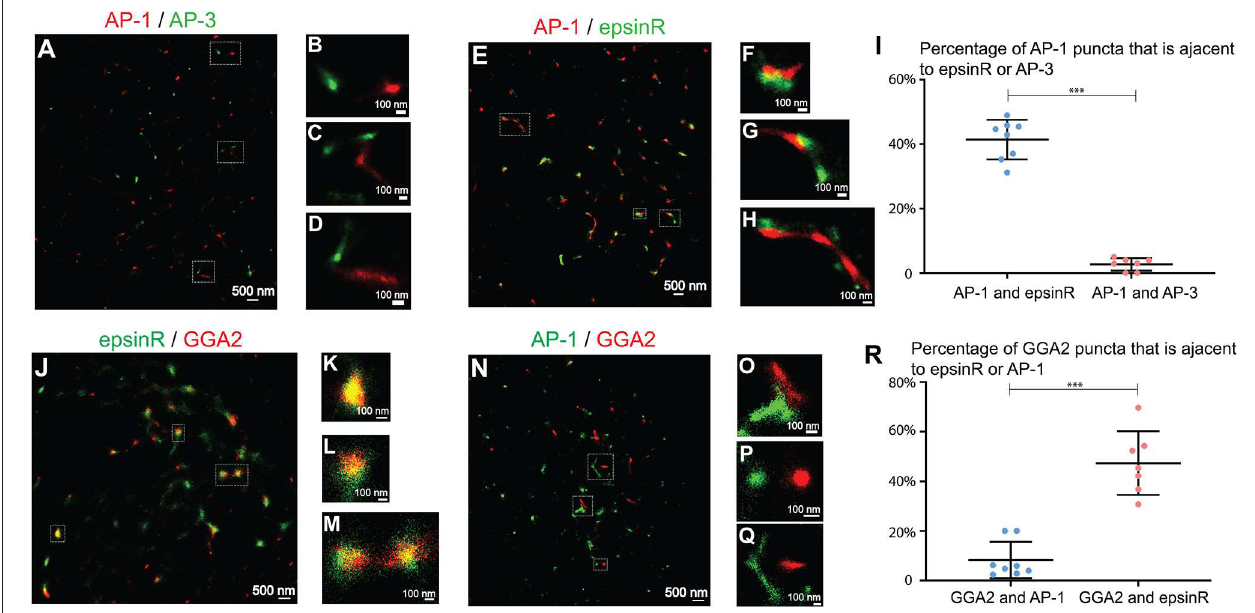
FIGURE 3 | Spatial relationship analysis between clathrin adaptors at the juxtanuclear area. (A–D,N–Q) COS7 cells were co-stained with antibodies against γ 1-adaptin and δ 3-adaptin or co-stained with antibodies against γ 1-adaptin and GGA2. Two-color STORM was then utilized to visualize localizations of AP-1 and AP-3 (A–D) and the localization of AP-1 and GGA2 (N–Q) . (E–H,J–M) . COS7 cells were transfected with epsinR-FLAG. Day 1 after transfection, cells were co-stained with antibodies against γ 1-adaptin and FLAG tag (E–H) or with antibodies against GGA2 and FLAG tag (J–M) . Two-color STORM was then utilized to visualize localizations of γ 1 and epsinR-FLAG and the localizations of GGA2 and epsinR-FLAG. The Magnified views of the indicated area in (A,E,J,N) were indicated in (B–D,F–H,K–M,O–Q) . The scale bar of each panel was indicated. (I,R) The percentage of AP-1 punctae that were associated with epsinR or AP-3 was quantified (I) and the percentage of GGA2 punctae that were associated with epsinR or AP-1 was quantified (R) (mean ± SD, based on ≥ 7 super-resolution images). *** p < 0.001 by two-tailed Student’s t -test. AP-1 and AP-3 were labeled by antibodies against γ 1 and δ 3, respectively. The super-resolution images showed the localization patterns of the indicated protein in the whole juxtanuclear area where the majority of the cargo adaptors were localized. Each dot in the graphs represents data of the whole juxtanuclear Golgi area of each individual cell. Quantification analyses were based on super-resolution images acquired from three independent repetitions for each experimental group.